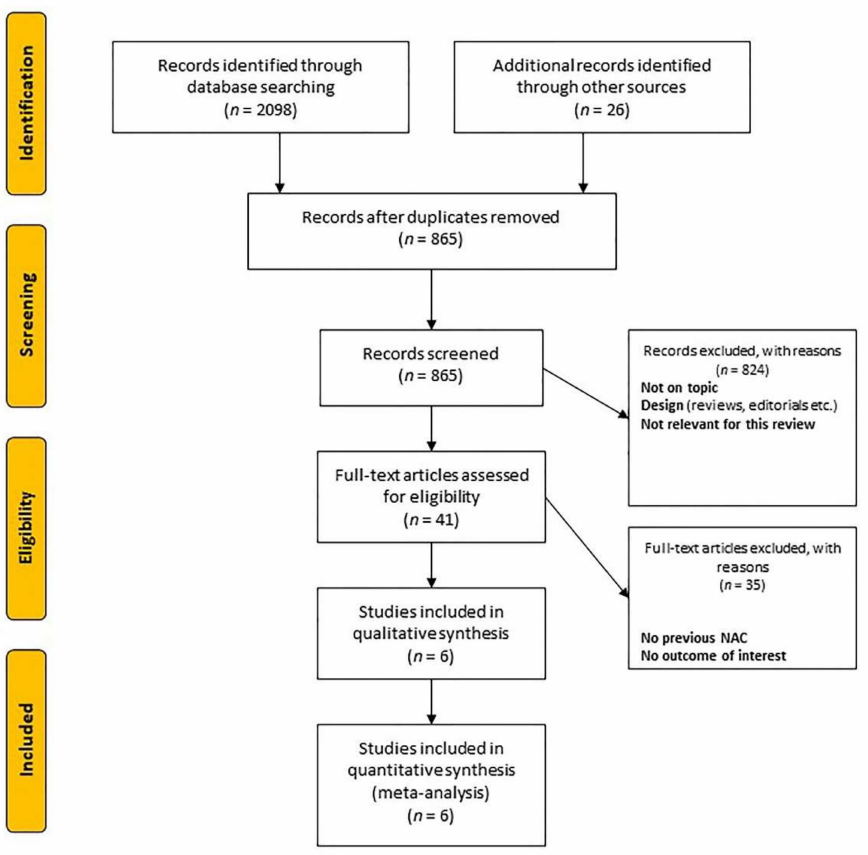
Figure 1. Flow diagram of the study